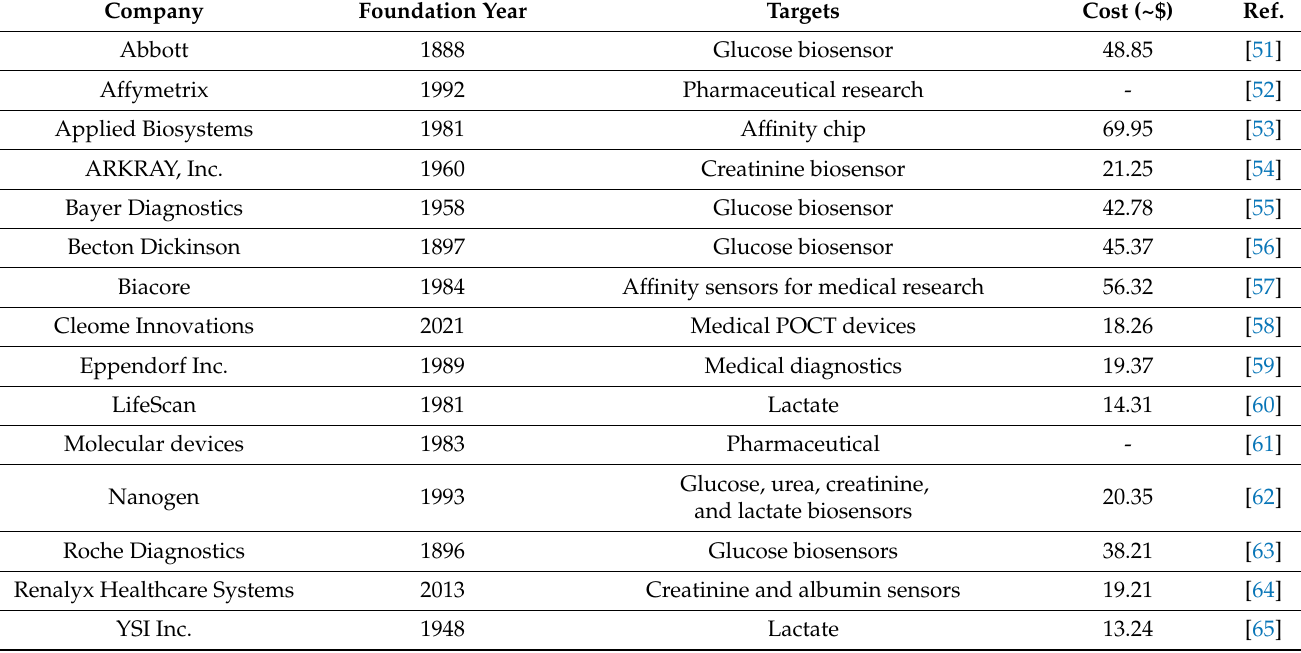
Table 1. Prominent biosensor companies and targets involved in the